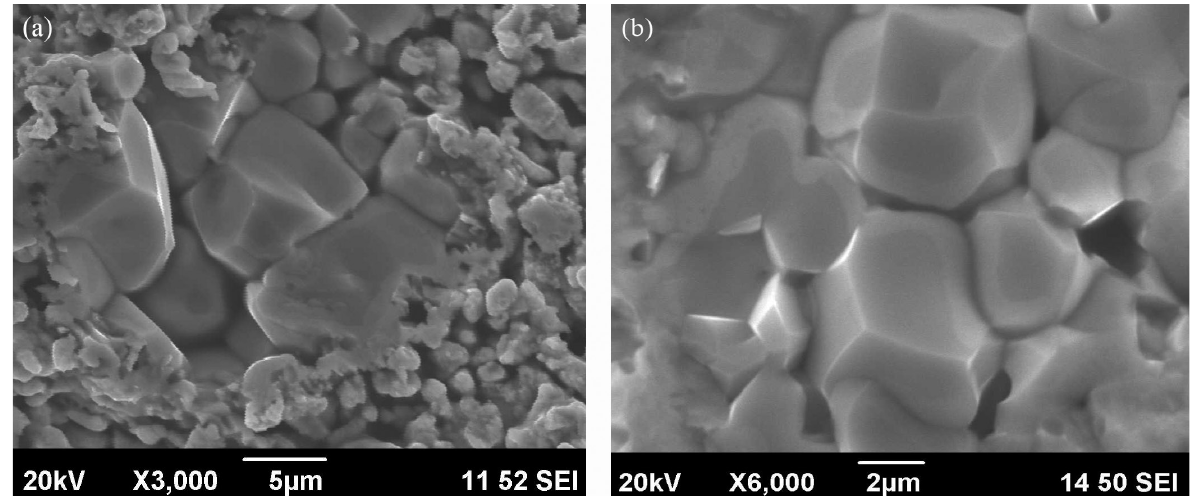
Figure 3. Cross-section SEM image of ( a ) SmCTO25 and ( b ) SmCTO50 composites.